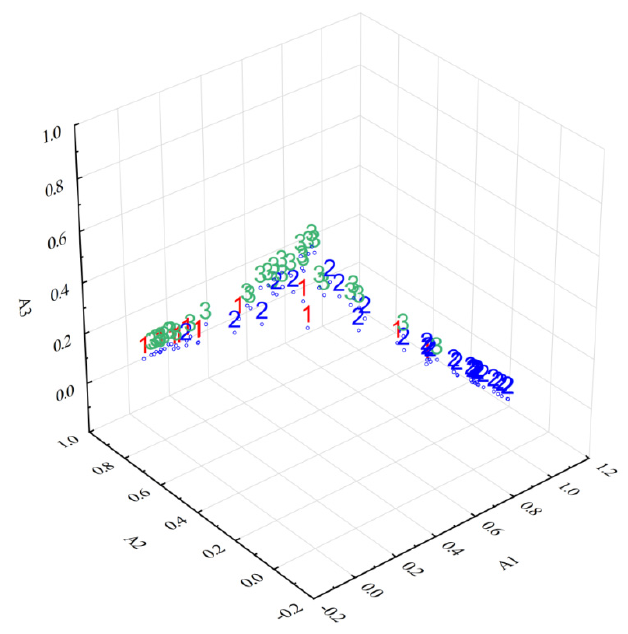
Figure 4. 3D scatterplot of DOMs corresponding to partitions A1, A2, and A3.